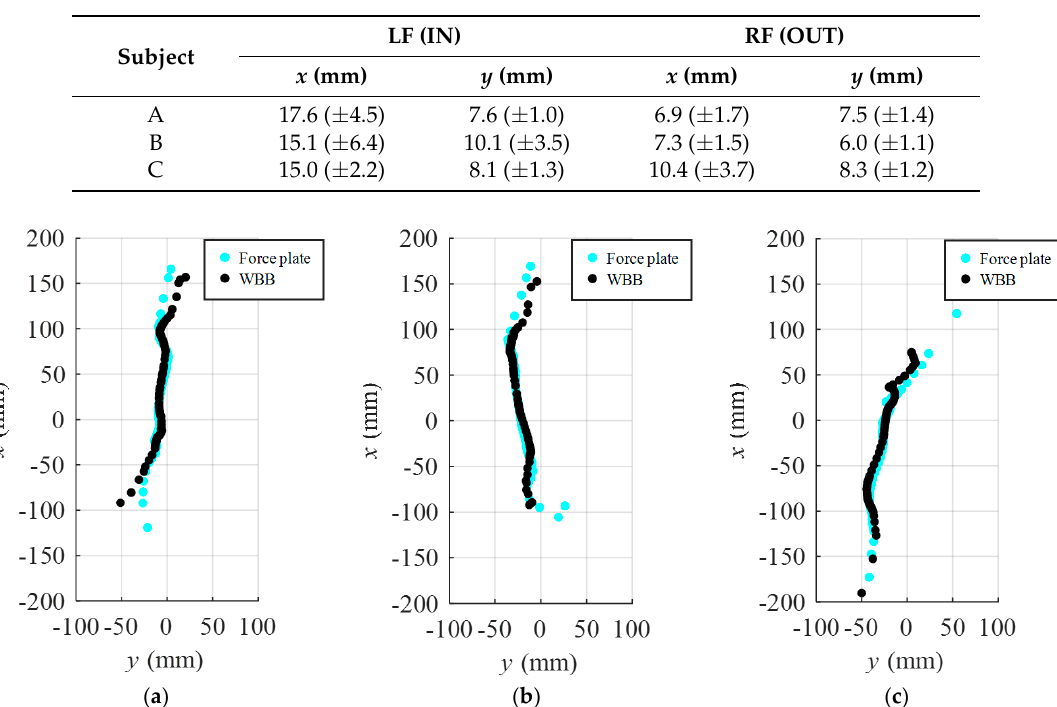
Table 6. Root-mean-square error (RMSE) of center of pressure (COP) comparing measurements from the Nintendo Wii Balance Board (WBB) with those from the force plate while walking along the curved path (counterclockwise—CCW).